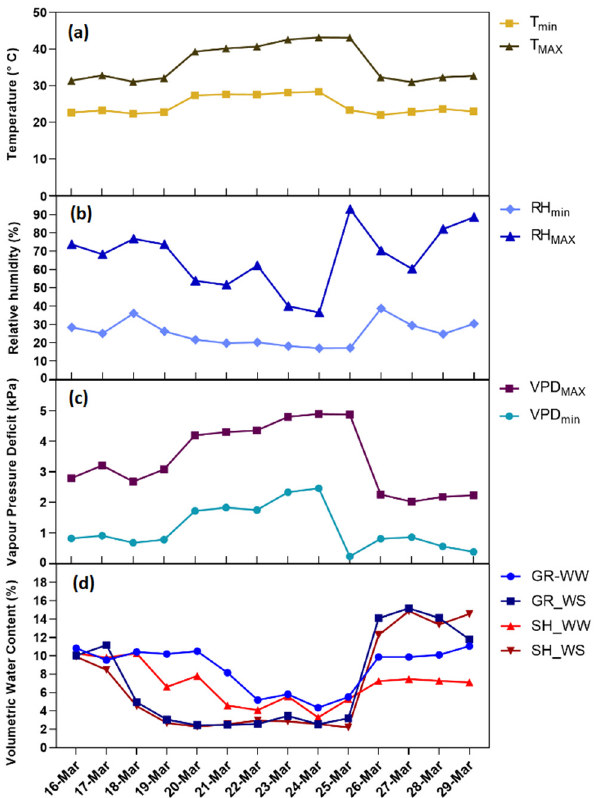
Figure 1. Environmental conditions during the experiment; ( a ) maximum and minimum daily ambient temperature; ( b ) maximum and minimum daily relative humidity; ( c ) maximum and minimum daily vapour pressure deficit; ( d ) volumetric water content.